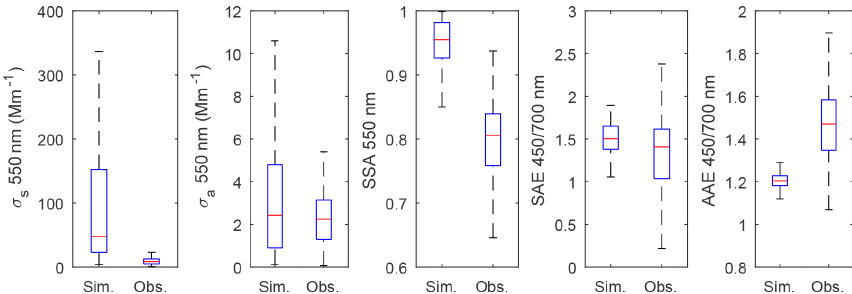
Figure 6. Comparisons between observed and simulated aerosol optical properties. Box plot of simulated and observed single scattering albedo (SSA), scattering Ångström exponent (SAE), absorption Ångström exponent (AAE), scattering ( σ s ) and absorption ( σ a ) coefficients from 9 to 13 March 2014 at the T3 site. Median values are shown in red lines, and the blue box indicates data between the 25th and 75th percentiles.